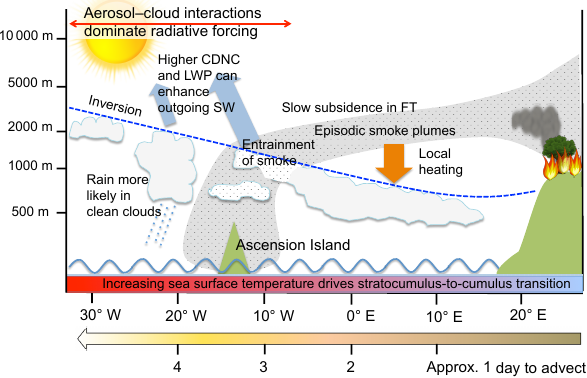
Figure 1. Schematic showing the large-scale situation in the south- east Atlantic, approximately along the pathway of the smoke aerosol. We focus here on a case in which the entrainment of smoke is simultaneous with the stratocumulus-to-cumulus transition, but smoke may also mix into the cloud deck closer to the African con-